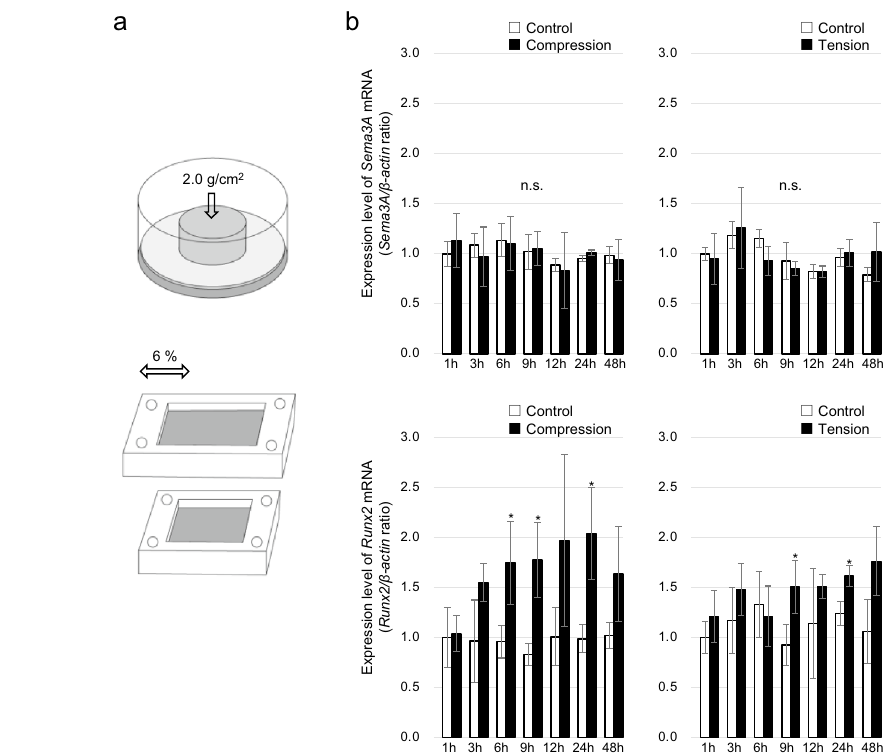
Figure 4. ( a ) The method used to apply compressive force or tension force. Cells were compressed continuously using a glass plate on a 6-well plate or stretched using a stretch chamber. ( b ) Sema3A and Runx2 mRNA quantification by RT-qPCR in osteoblasts after compression and tension stress. The bars represent Sema3A and Runx2 mRNA levels relative to β-actin mRNA levels. There were no significant differences in Sema3A expression in either mechanical compression or tension stress compared to controls. (n = 3) Data are presented as mean ± SD. * p < 0.05, ** p < 0.01, n.s. = no